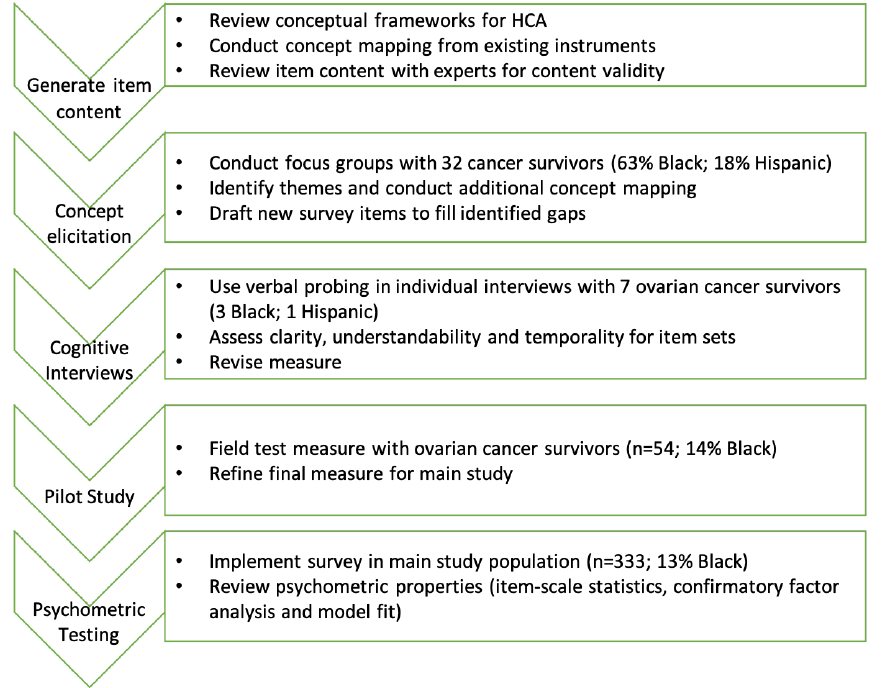
Figure 1. Steps to develop HCA Accommodation and Acceptability Measures for diverse cancer survivors.